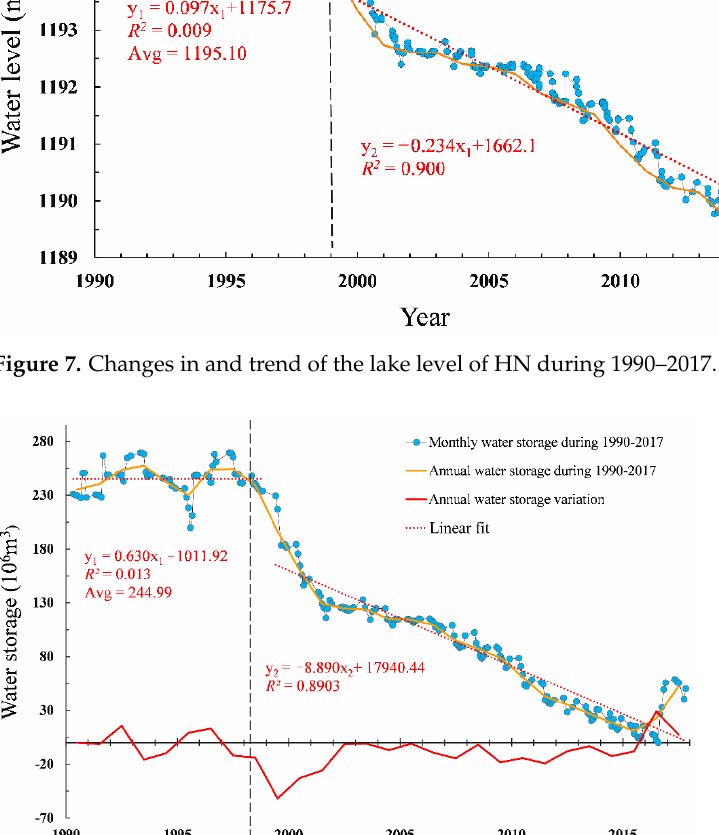
Figure 8. Changes in and trend of the water storage of HN during